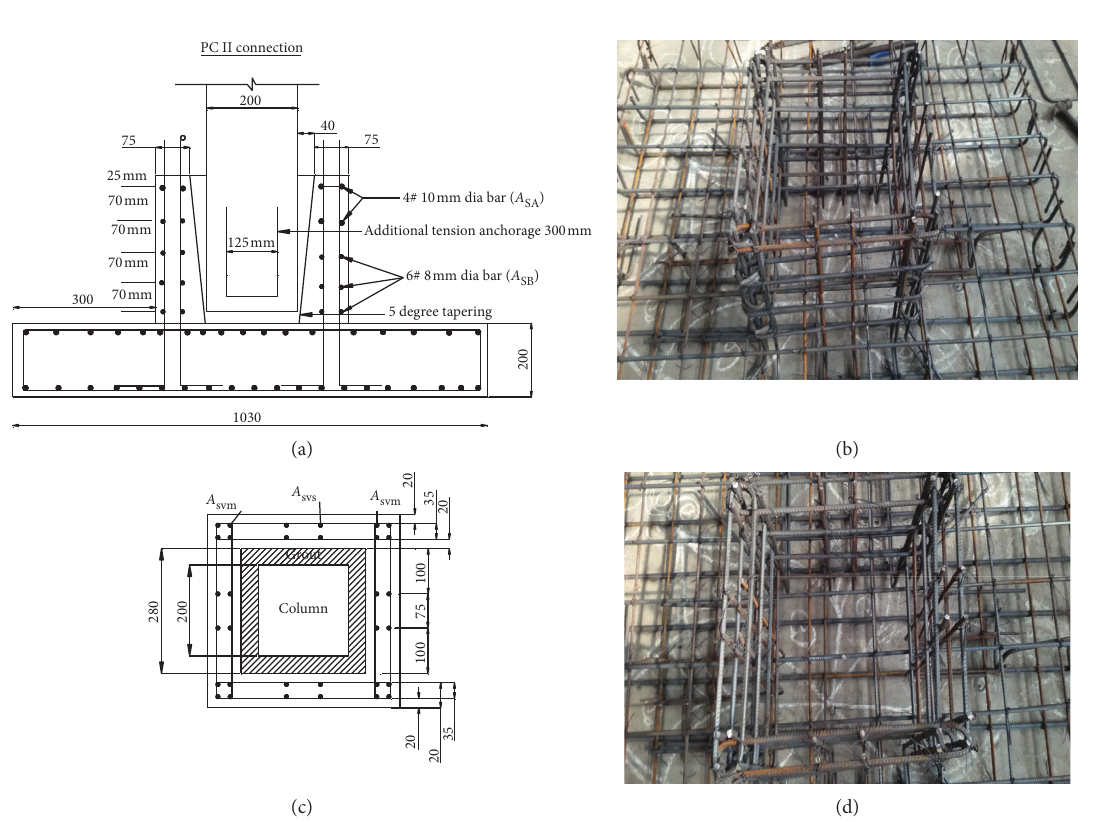
Figure 8: Reinforcement details of PC II